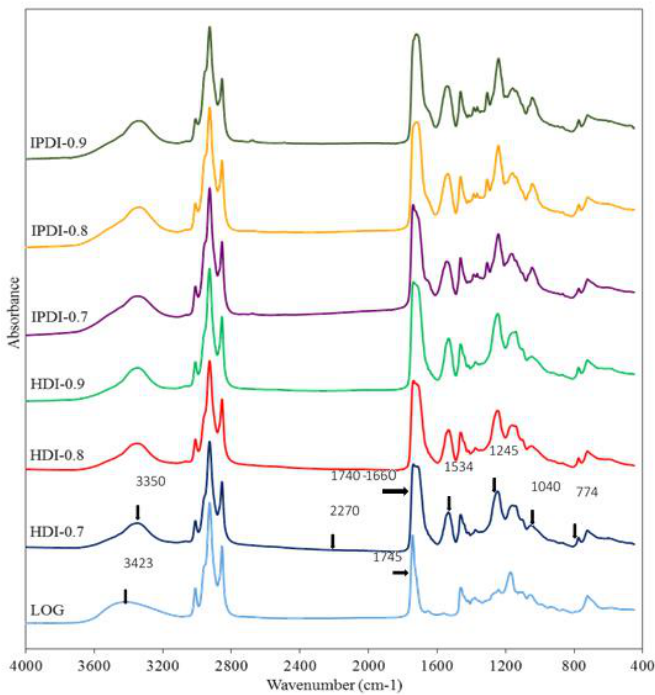
Figure 4. FTIR spectra of LOG and COOH-containing prepolymers synthesized using different NCO/OH mole ratios.